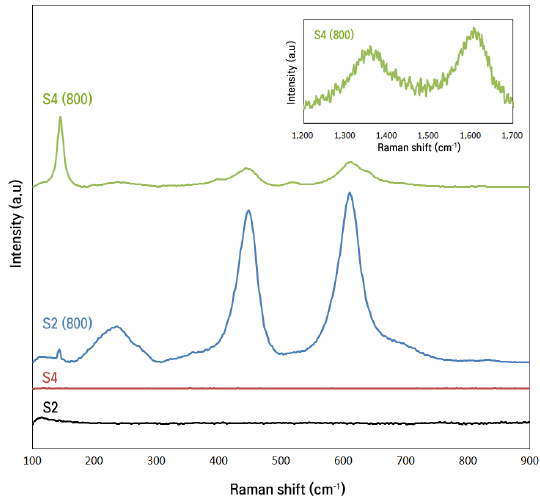
Figure 8. Raman spectrum of S2, S4, S2(800) and S4(800).